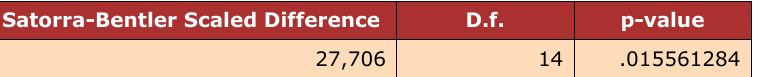
Table 11. Difference of adjusted Satorra-Bentler Chi Squared indexes